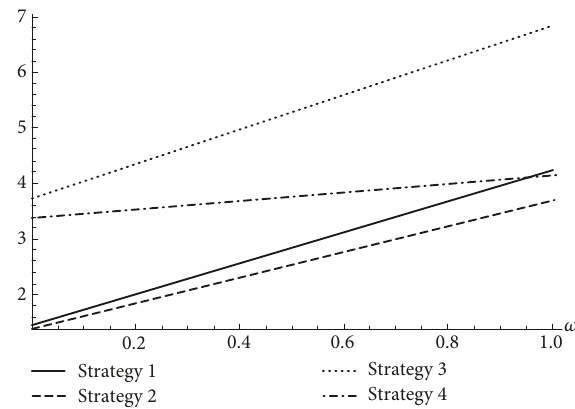
Figure 6: Revenue of film series under different star selection